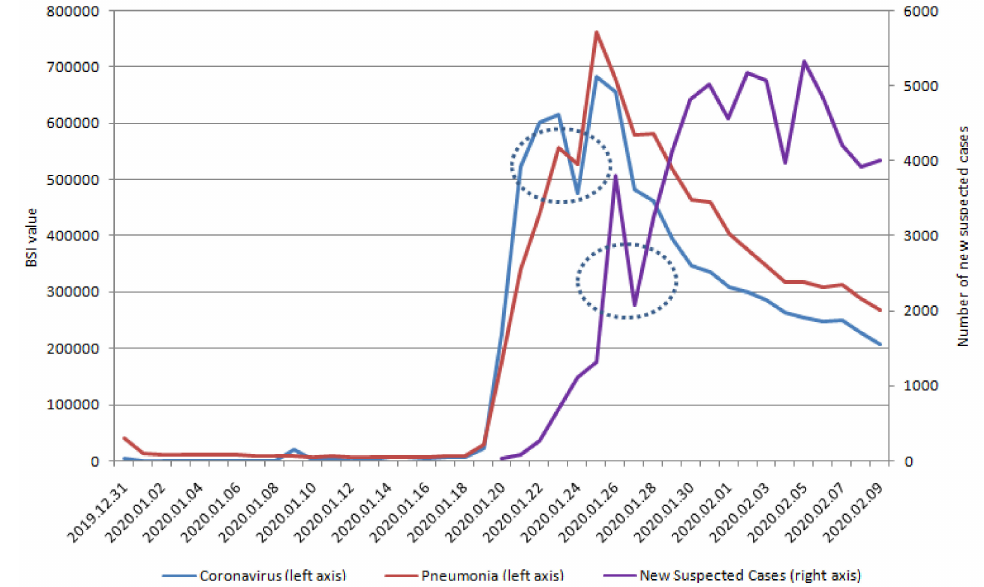
Figure 2. New suspected cases of COVID-19 and lag days of coronavirus and pneumonia.